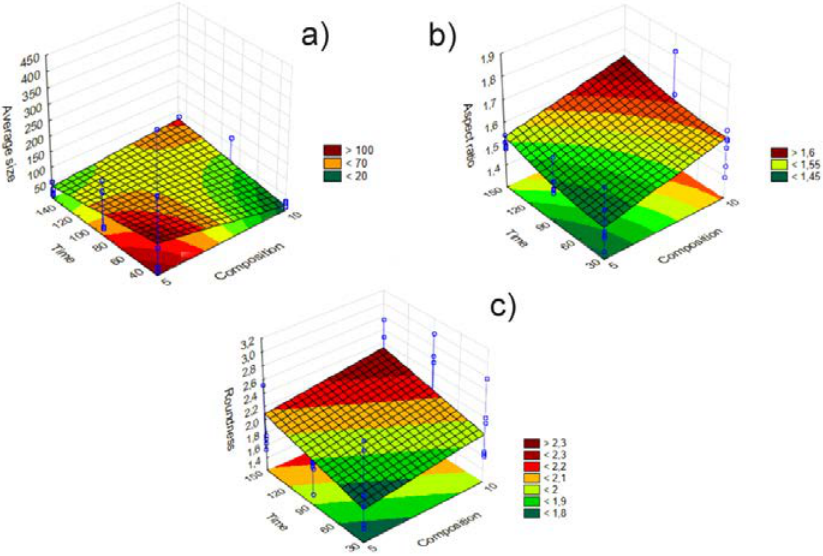
Figure 5. Surface plot diagrams of the SA products, investigating the effect of mixing time and solvent/antisolvent ratio on mean particle size, aspect ratio, and roundness; describing DS. Blue lines represent the standard deviation of the data. Figure 5( a ) represents the surface plot diagram of the mean particle size of the particles besides the modification of mixing time and solvent/antisolvent ratio (composition). Figure 5( b ) represents the surface plot diagram of the aspect ratio values besides the modification of mixing time and composition. Figure 5( c ) represents the surface plot diagram of roundness besides the modification of mixing time and solvent/antisolvent ratio (composition).